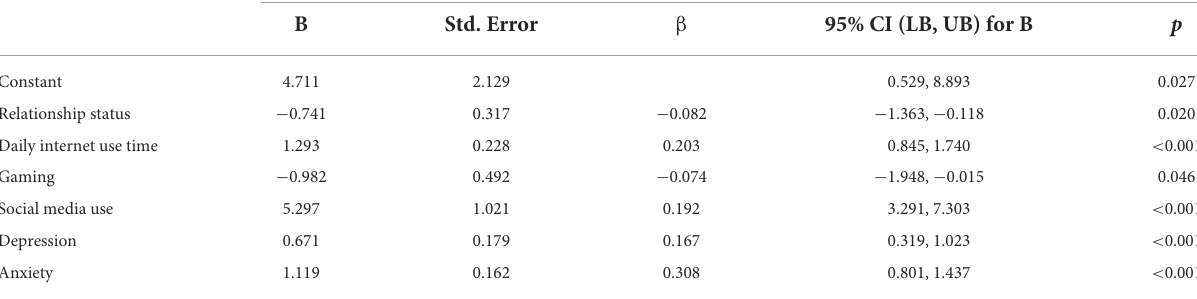
TABLE 3 Predictive models for problematic Facebook